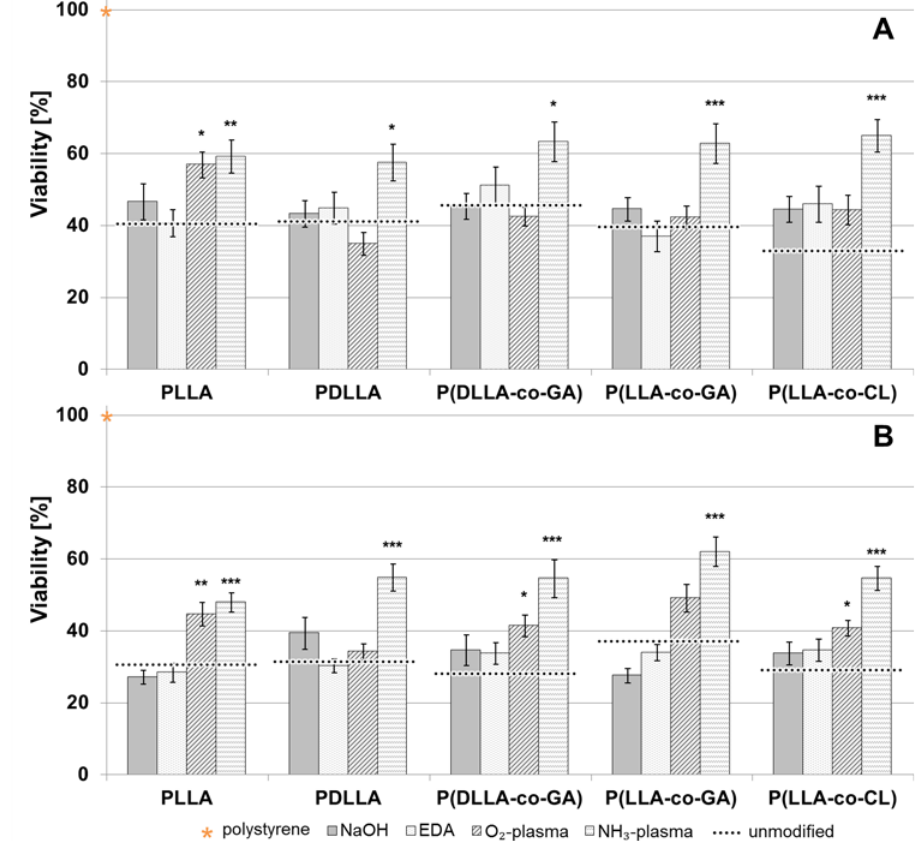
Fig 4. Cell viability measurements of HCAEC and HUVEC grown on unmodified and modified polymer surfaces. Relative cell viability of HCAEC (A) and HUVEC (B) after 72 h incubation on the polymer surfaces activated by means of wet- and plasma-modification, n = 6 (for each cell type). Dotted lines indicate the relative viability of respective unmodified polymers. The viability of polystyrene was set to 100% (asteric). Data are presented as mean of three independent experiments ± SEM. (p * (cid:3) 0.05, p ** (cid:3) 0.01, p *** (cid:3)